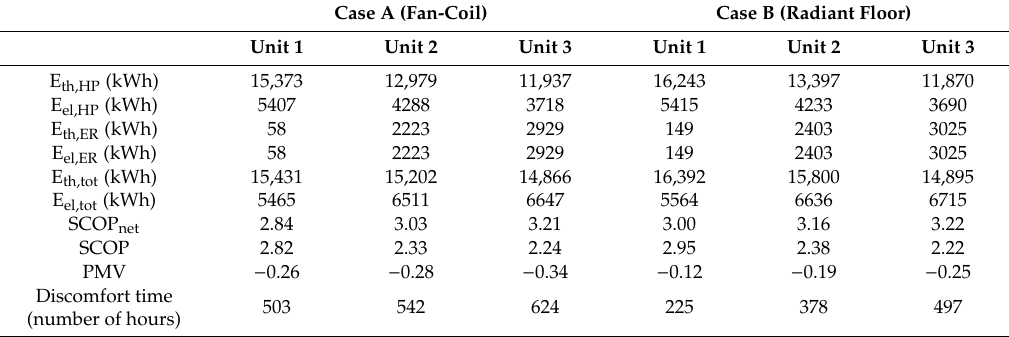
Table 3. Seasonal energy consumptions and key performance indicators of the simulated systems without